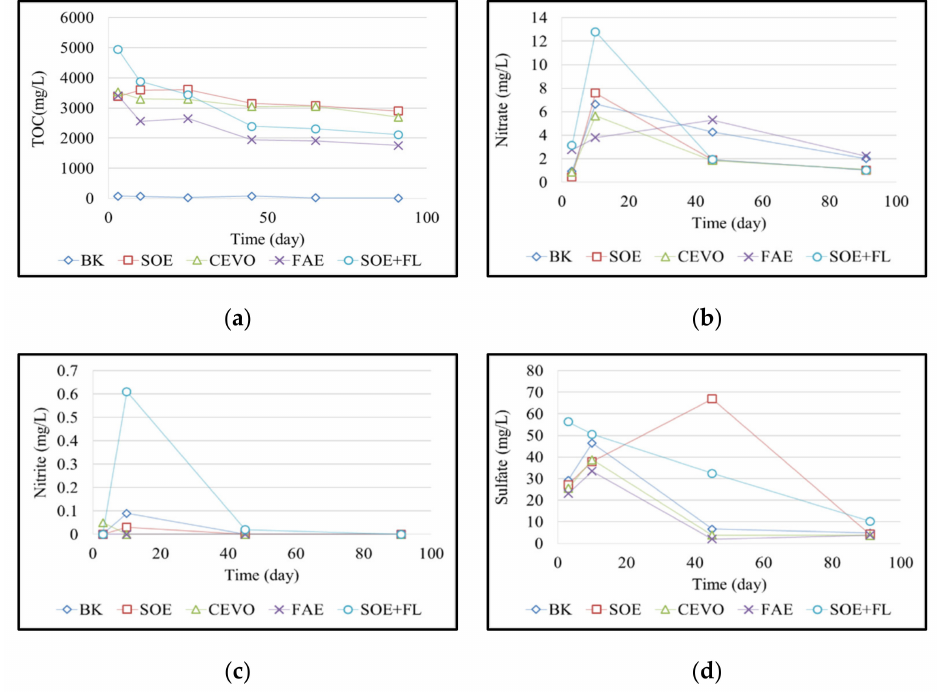
Figure 4. Water quality parameter variation in the microcosm tests: ( a ) TOC; ( b ) nitrate; ( c ) nitrite; and ( d )